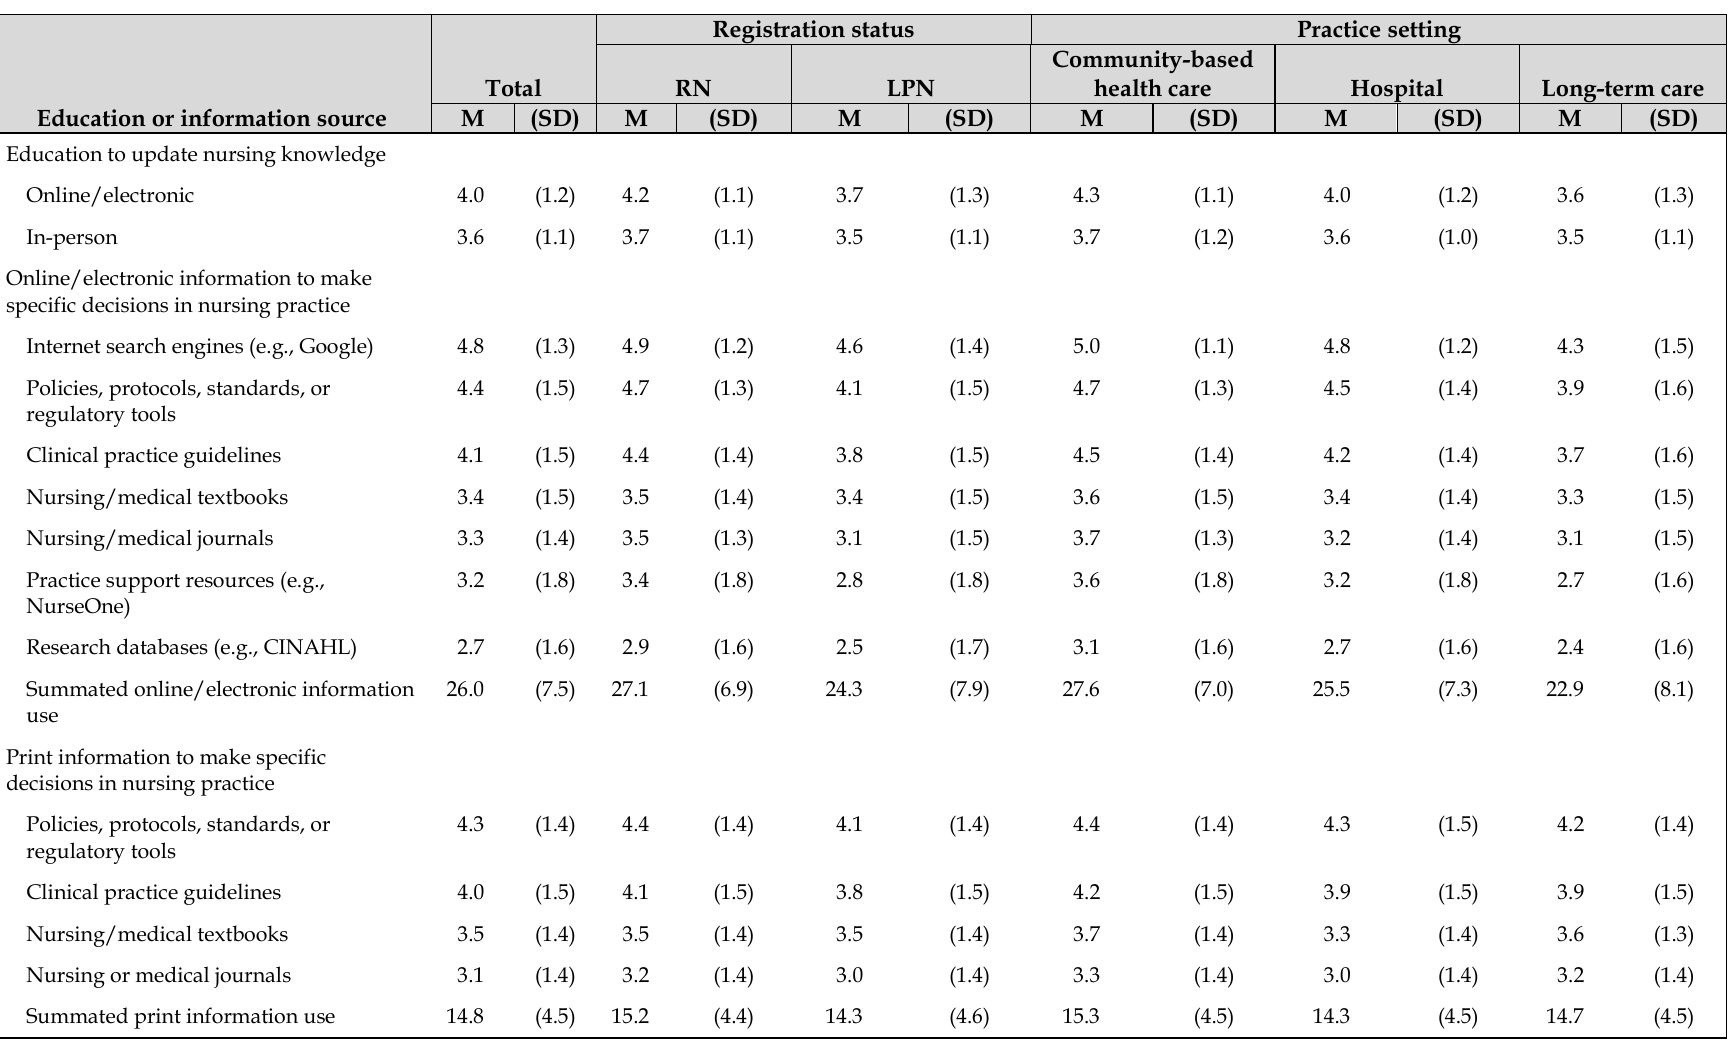
Table 4 Direct access to communication tools, by practice